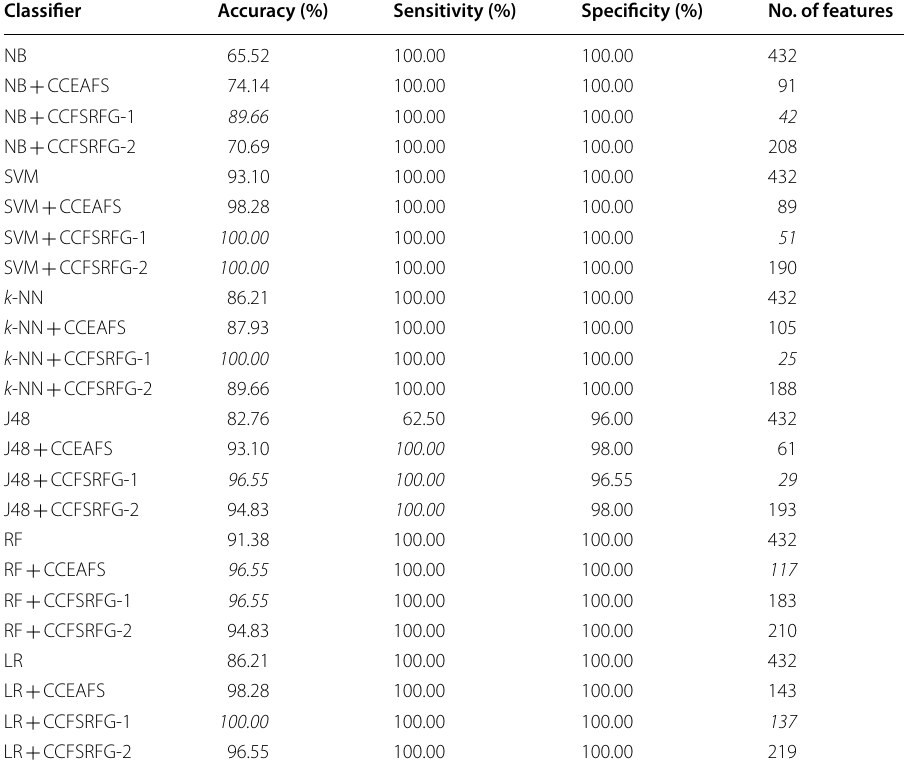
Italic signifies the improvements of the proposed approach over existing techniques Table 12 Summary of results for the QSAR Oral Toxicity Dataset